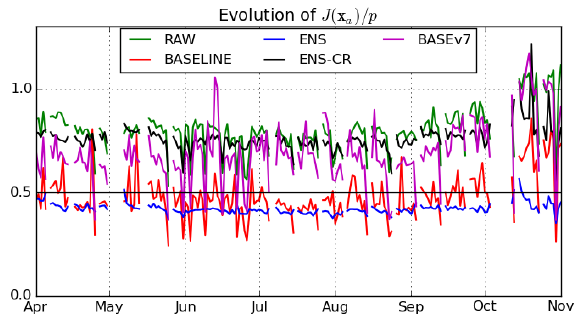
Figure 6. Time series of J( x a )/p for the BASCOE experiments RAW, BASELINE, ENS, ENS-CR and